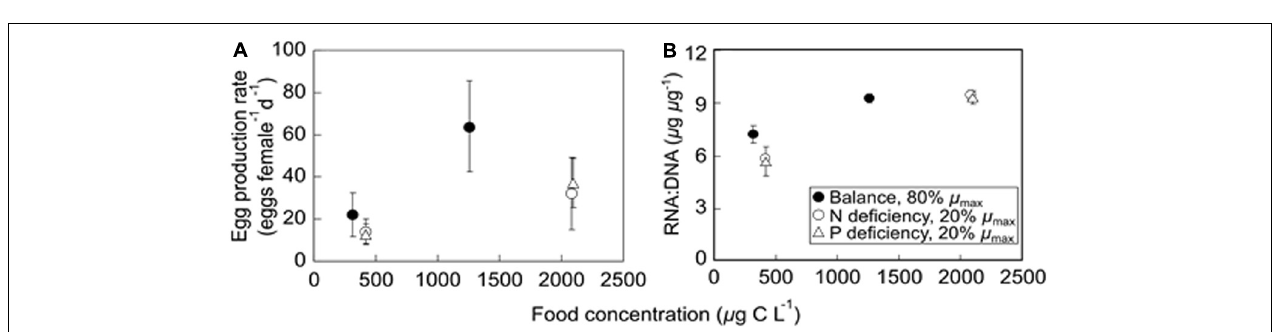
FIGURE 5 | The ratio of ω 6-polyunsaturated fatty acid (PUFA) contents ( µ g mg C − 1 ) between A. tonsa and algae ( ω 6-PUFA Z/f) as a function of algal C:X ratio (here, X = N or P) and food quantity, fitted to the multiple regression model with the linear term algal C:X ratios, food quantity and the interactions between the two. (A) ω 6-PUFA Z/f as a function of algal C:N and food quantity, and (B) ω 6-PUFA Z/f as a function of algal C:P and food quantity. Data of ω 6-PUFA Z/f, algal C:X and food quantity were transformed using Log 10 ( x ). The mesh grid is the 3D surface plot of the model prediction. Observations are represented by ball-and-stick symbols where the stick is the projection of the observation onto the surface plot.